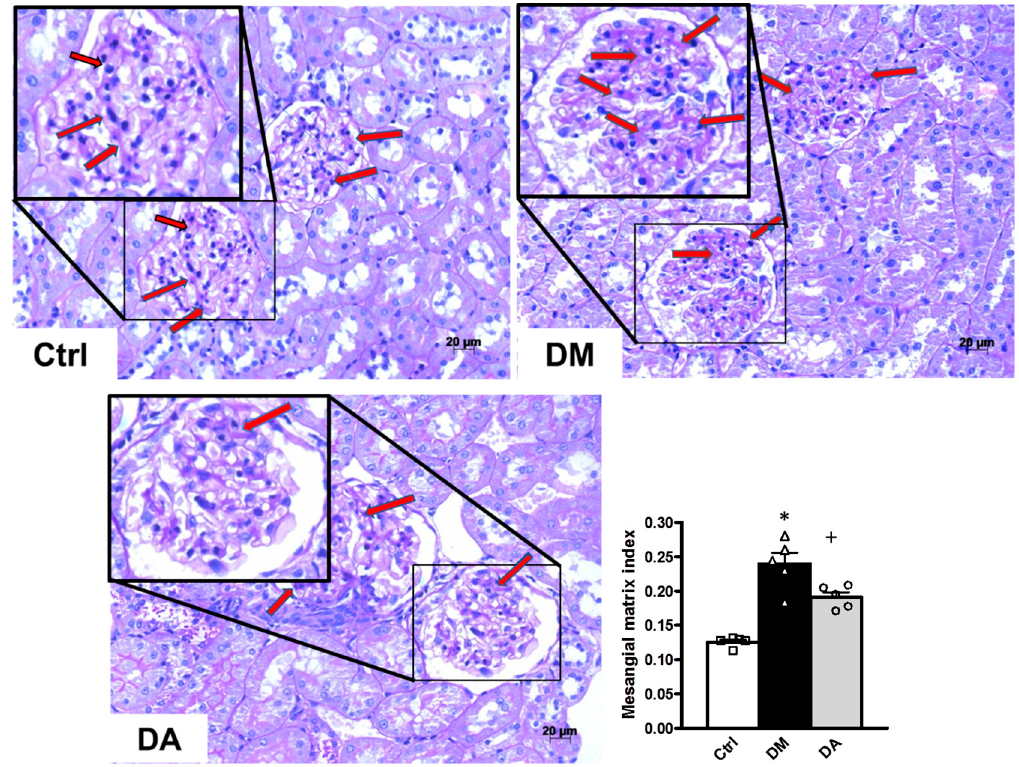
Figure 4. Mesangial matrix and quantitative analysis of rat kidneys. Representative photomicrographs of one kidney cortex section of each experimental group. Control (Ctrl) with no changes in glomeruli mesangium seen in light purple (arrows). Diabetes (DM) illustrates expansion of the mesangium (arrows), which is thicker and denser than the one of control group. Diabetes + Allicin (DA) depicts a mesangium (arrows) with characteristics between the control and the DM groups. Periodic acid-Schiff (PAS stain), 200× original magnification. Graph shows quantitative analysis of mesangial matrix index. Values are expressed as mean ± SEM of n = 5 * p < 0.001 vs. Ctrl; + p < 0.001 vs. DM.